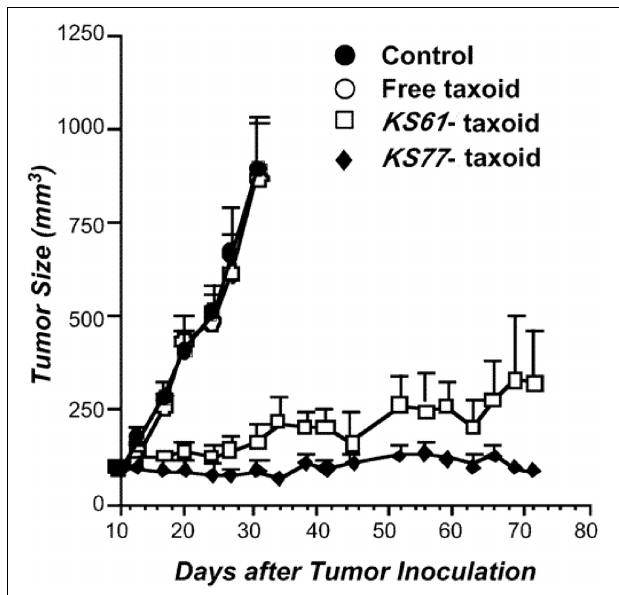
FIGURE 8 | Antitumor activity of the KS77/KS61–PTX conjugates against A-431 xenografts in SCID mice (Ojima et al., 2002).